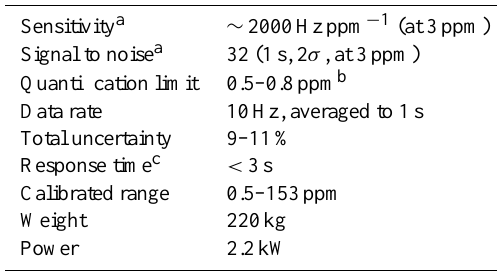
Table 1. Summary of typical H 2 O CIMS performance metrics dur- ing the MACPEX